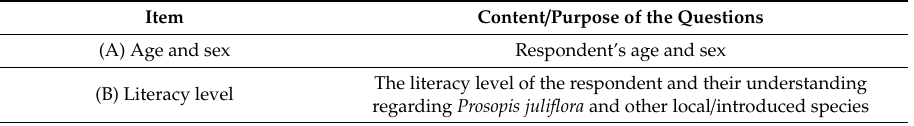
Table 2. Information collected through the semi-structured